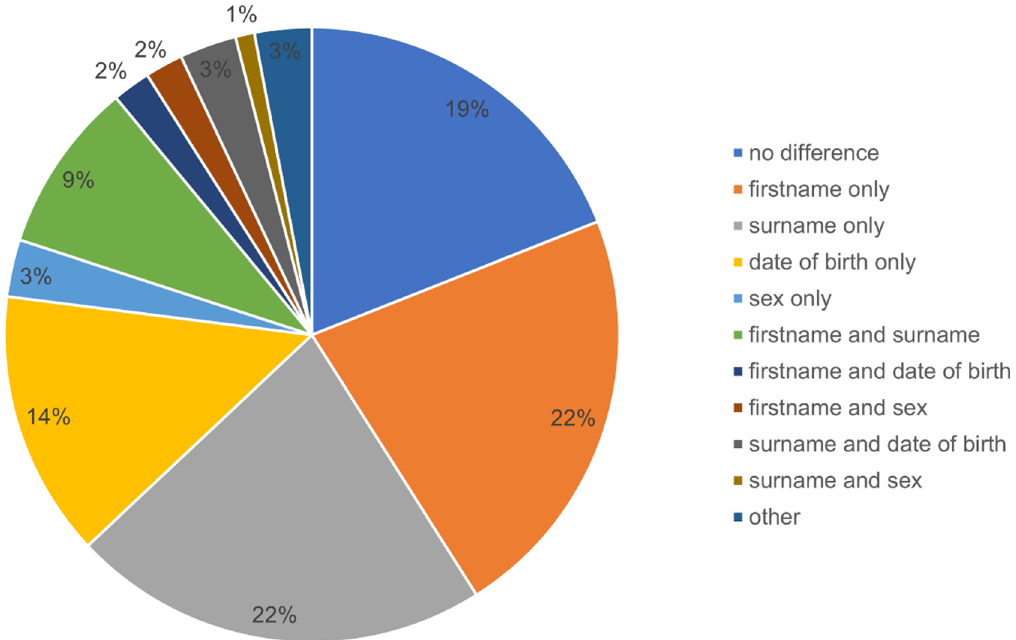
Figure 5: Proportion of comparison pairs with value mismatches among linkage variables for duplicates identified between